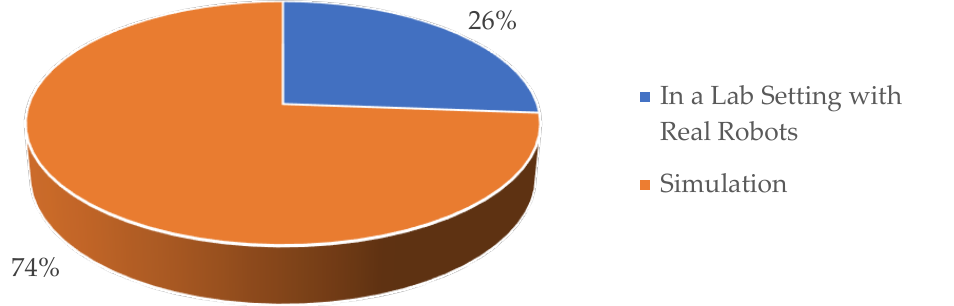
Figure 5. Categorization of the studies based on the experimental setup.